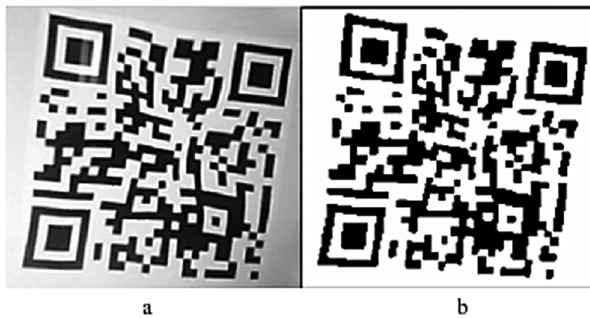
Figure 10: Binarization e ff ect diagram: ( a ) Before binarization and ( b ) After binarization.